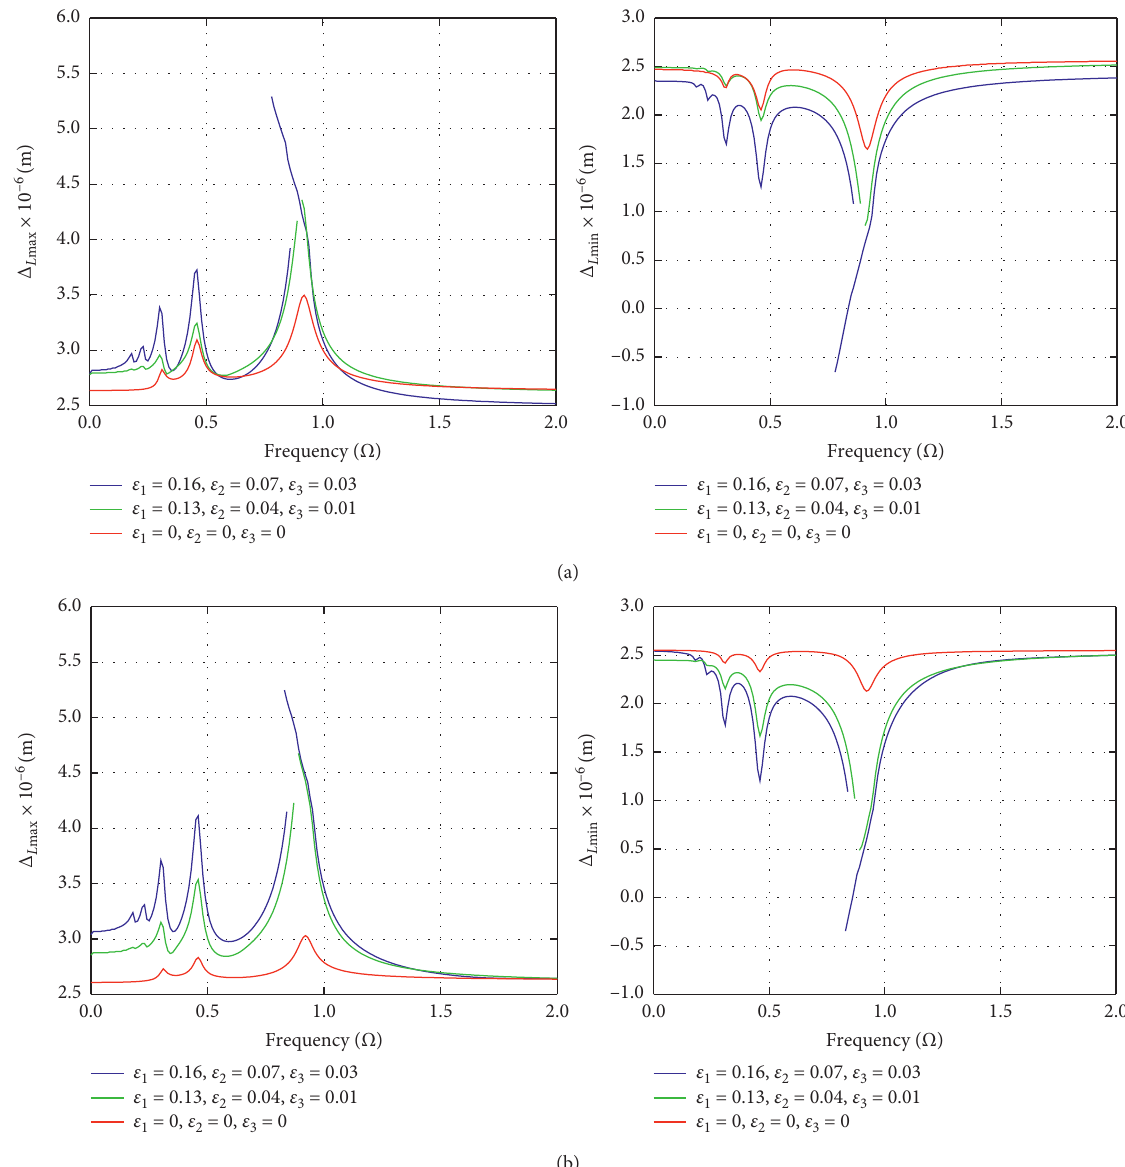
Figure 9: Influence of time-varying meshing stiffness on amplitude frequency characteristic curve of the system. (a) Constant backlash models and (b) dynamic backlash